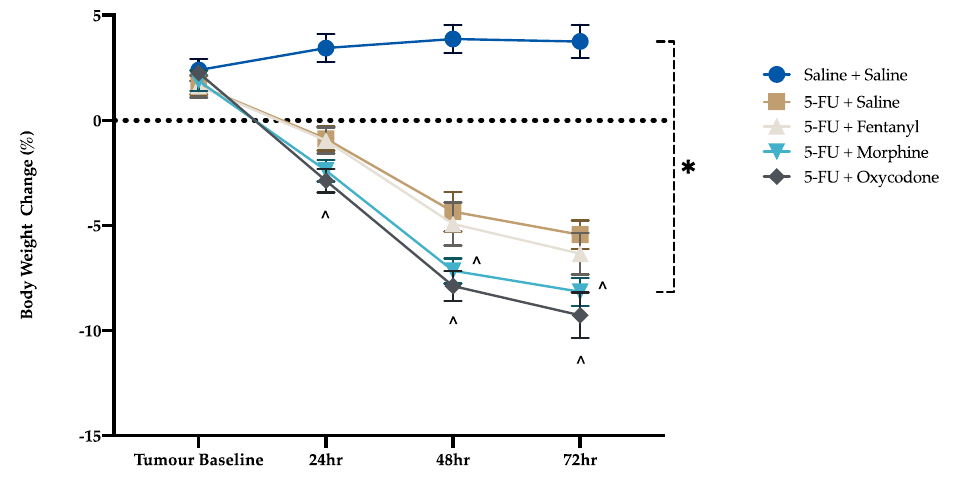
Figure 4. Body weight change. Data presented as mean % change in body weight ± standard error of the mean. * p < 0.05 compared to saline, ˆ p < 0.05 compared to 5-FU. Saline + Saline (n = 11), 5-FU + Saline (n = 12), 5-FU + Fentanyl (n = 12), 5-FU + Morphine (n = 12) and 5-FU + Oxycodone (n = 12) at all time-points.